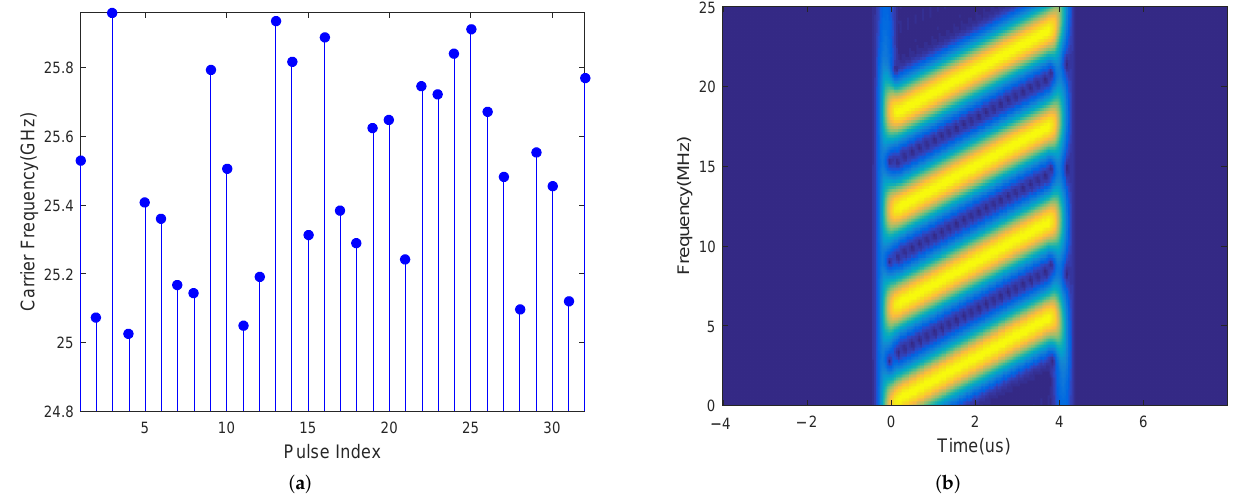
Figure 3. ( a ) Sequence of carrier frequency. ( b ) SFA-OFDM radar signal in the time– frequency